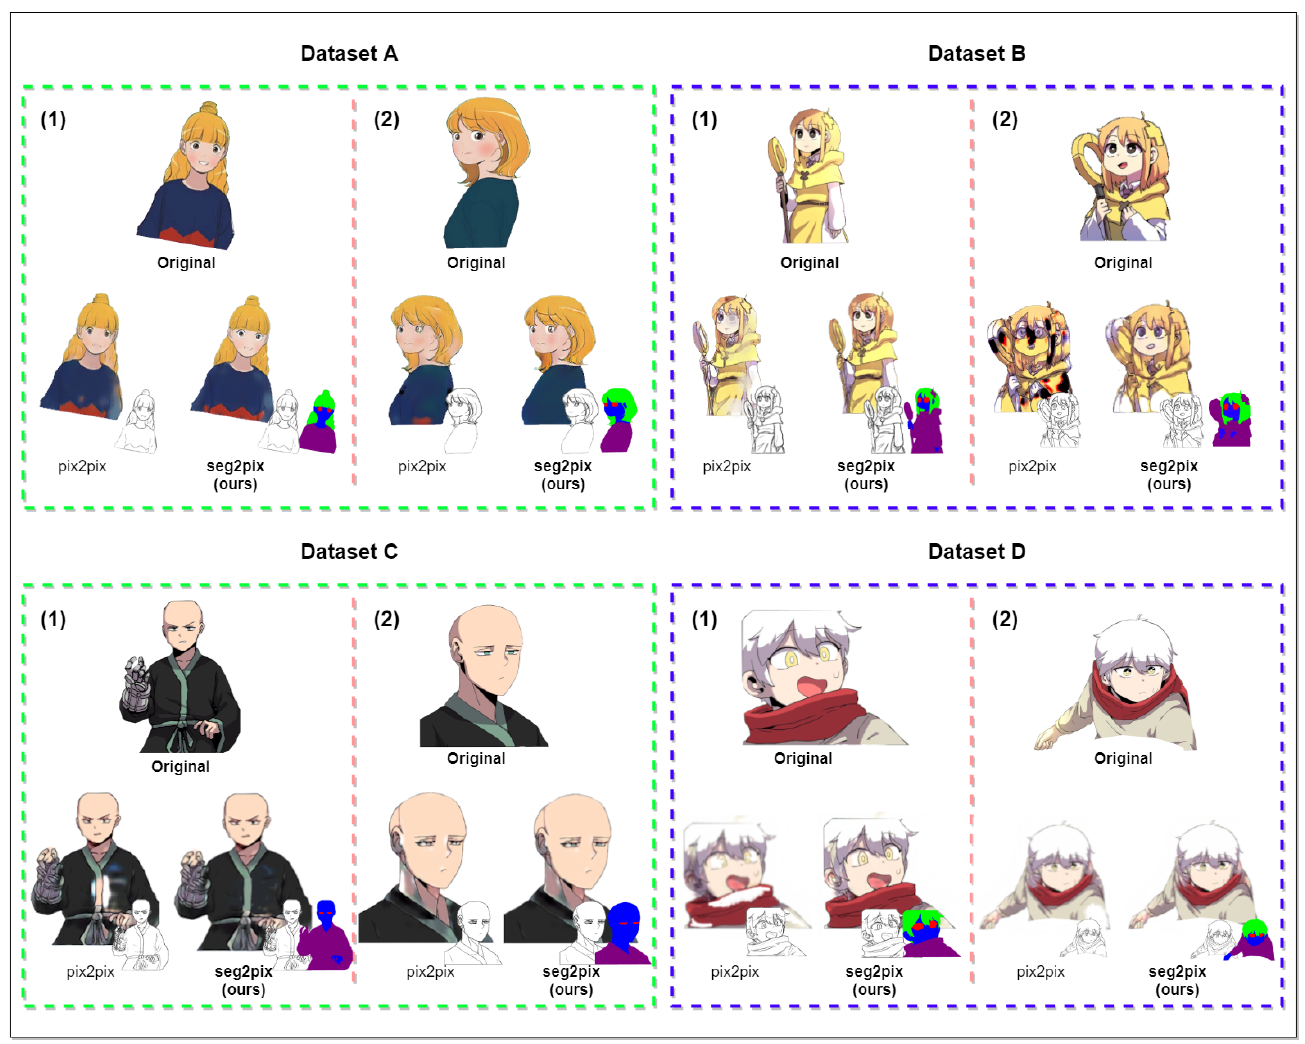
Figure 9. The Pix2pix generated images (1) from Dataset B and (2) from Dataset D show only slight differences in comparison to the Seg2pix output. However, the other Seg2pix generated images show very clear differences in the color bleeding and quality compared to the Pix2pix generated image trained on the same ground truth. Specifically, for the Pix2pix result (2) from Dataset B and (1) from Dataset C, these show a very low-quality color distribution between the skin and